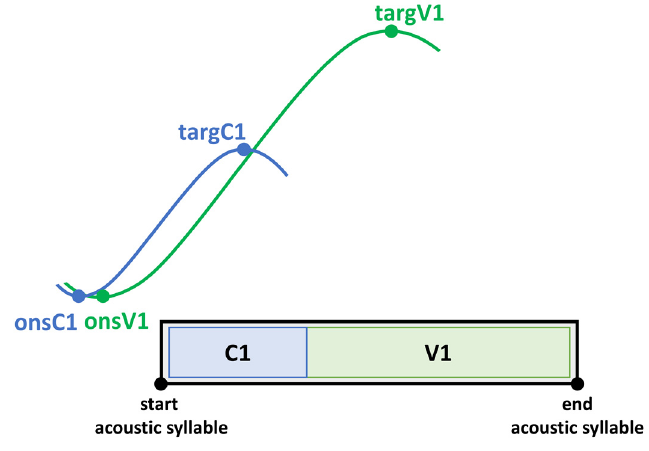
Figure 4. Coordination of articulatory gestures and acoustic segments within a CV syllable. As the vowel is the most sonorous element in the syllable it is therefore the most important domain for prominence-induced changes within the stressed syllable. Coordination patterns were calculated for the gestural onset (onsV1) and the gestural target (targV1) of the vocalic tongue body movement with respect to the acoustic syllable. Negative values indicate that the landmark lies before the acoustic syllable. Positive values indicate an achievement within the acoustic syllable.